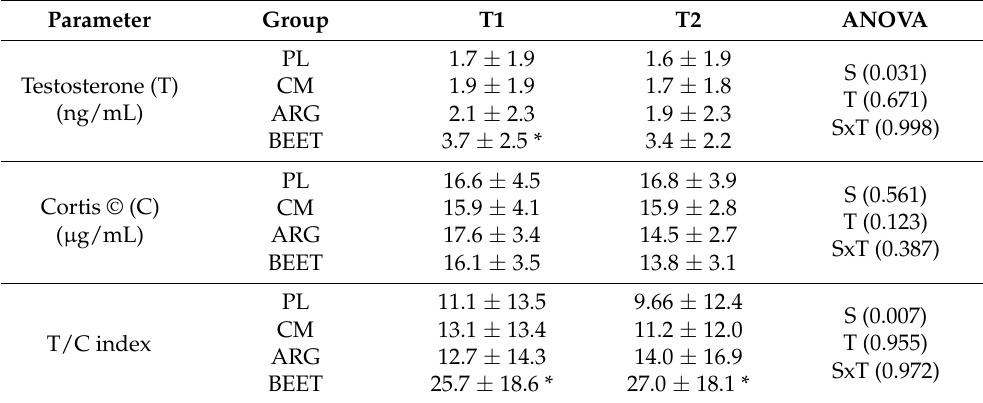
Table 5. Testosterone and cortisol levels at the beginning (T1) and end (T2) of the intervention with NO precursors for 6